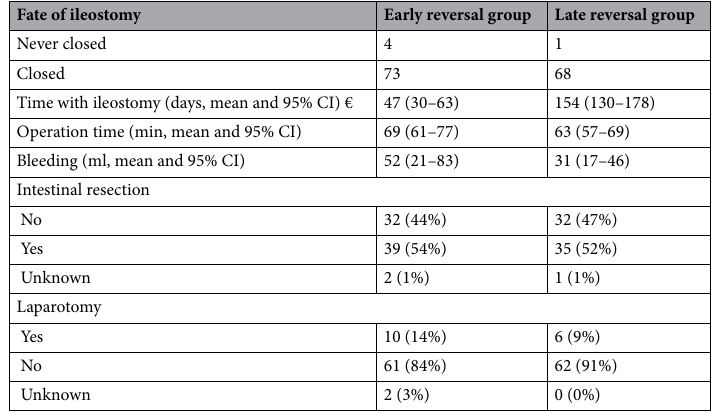
Table 3. Fate of the loop ileostomy, time to stoma reversal and surgical procedure at reversal in the two groups. €, missing data; 4 in the early group and 1 in the late group; CI, 95% Confidence Interval.